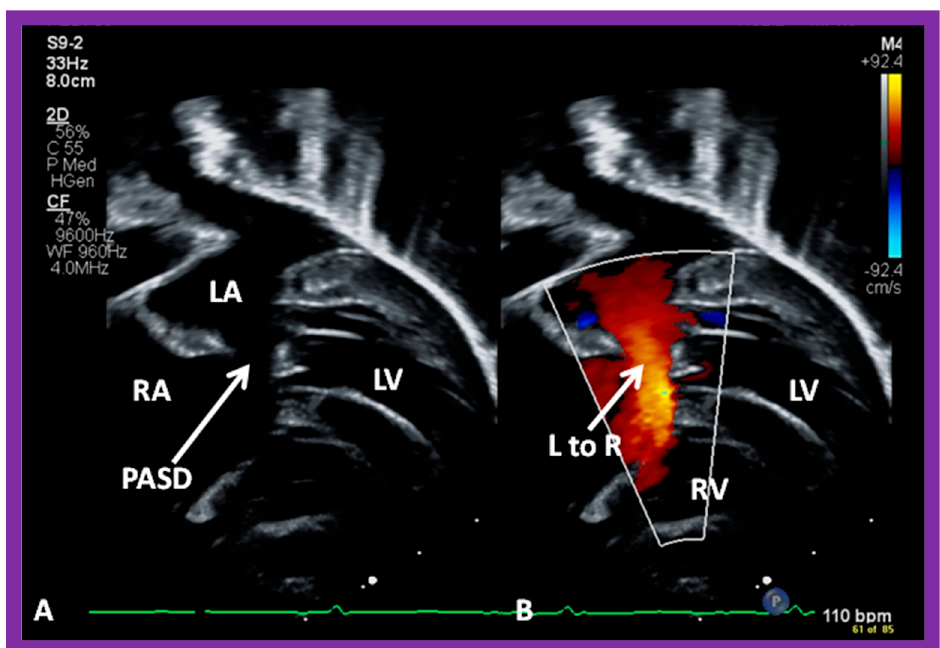
Figure 8. Echo images from modified subcostal four-chambered views illustrating an ostium primum atrial septal defect (PASD) ( A ) with shunting left-to-right (arrow in ( B )). Left atrium (LA), left ventricle (LV), right atrium (RA), and right ventricle (RV) are labeled.